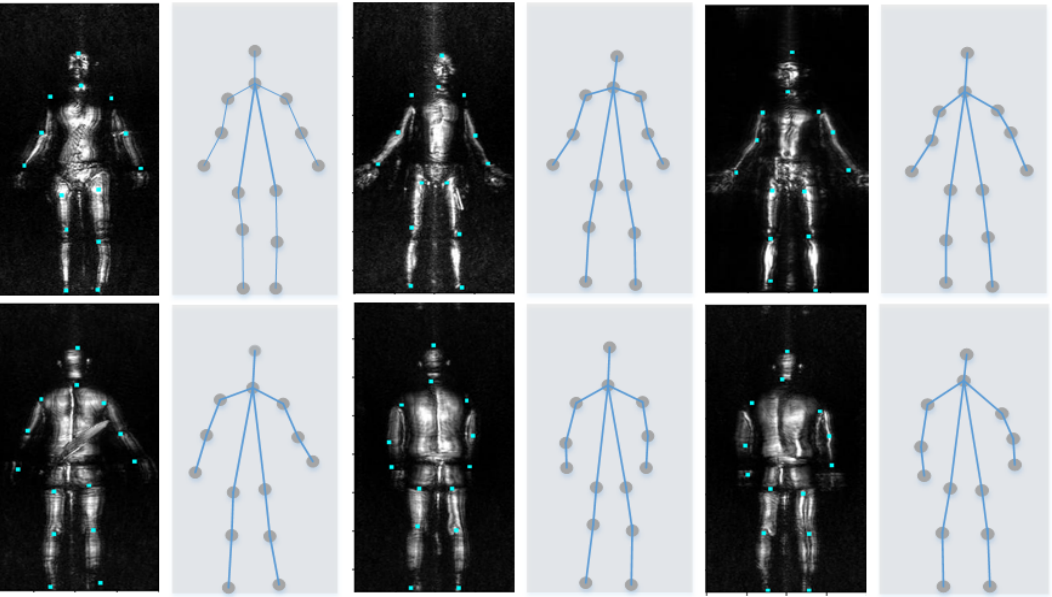
Figure 7. Results of the posture estimation.